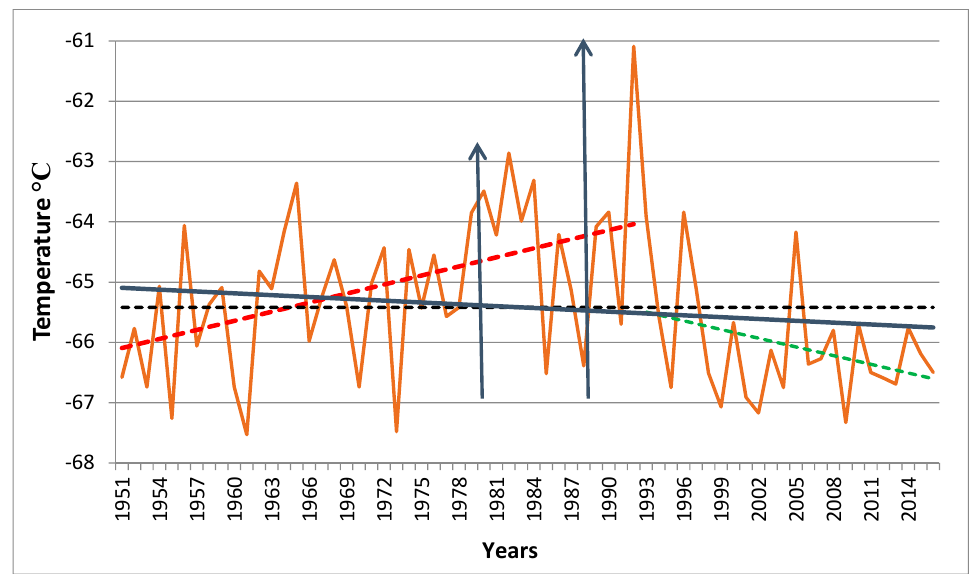
Figure 2. The distribution pattern of the lower stratospheric temperature time series at 50 hPa lower stratospheric temperature (LST) in wintertime in the period 1951–2016. The average value for the whole period (black dotted line), the trends displayed for the whole period (blue line color), the first half period 1951–1992 (red dotted line), and the second half period 1992–2016 (green dotted line) are also shown. The two upward pointing arrows are the warmest years, 1982 and 1992.